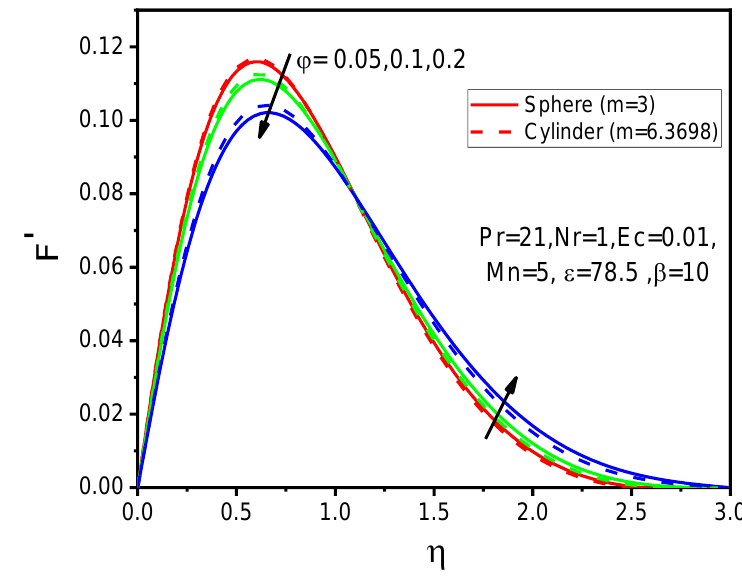
Figure 11. (Case b): Variations of F (cid:48) for φ = 0.05, 0.1, 0.2 against η